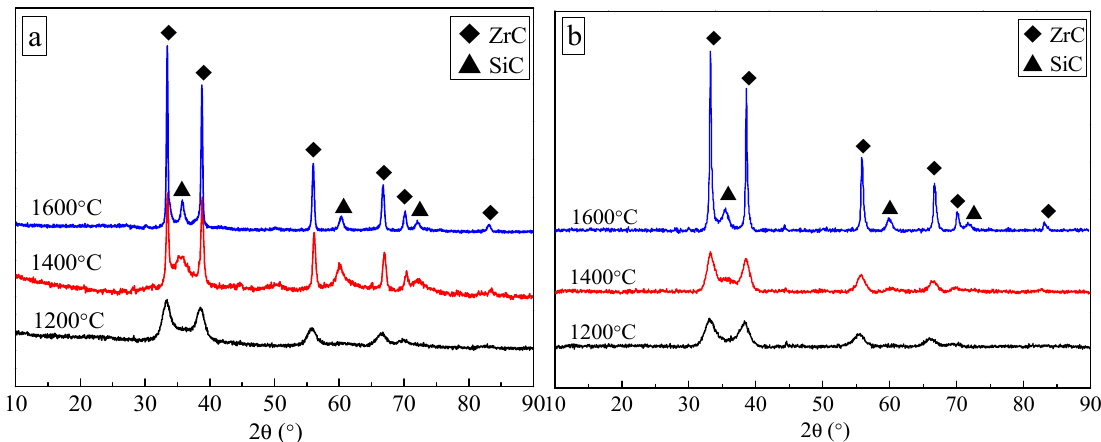
Figure 3. XRD patterns of SiC–ZrC ceramic fibers through ( a ) H 2 –Ar process and ( b ) Ar–Ar process up to various temperatures of 1200, 1400 or 1600 °C.